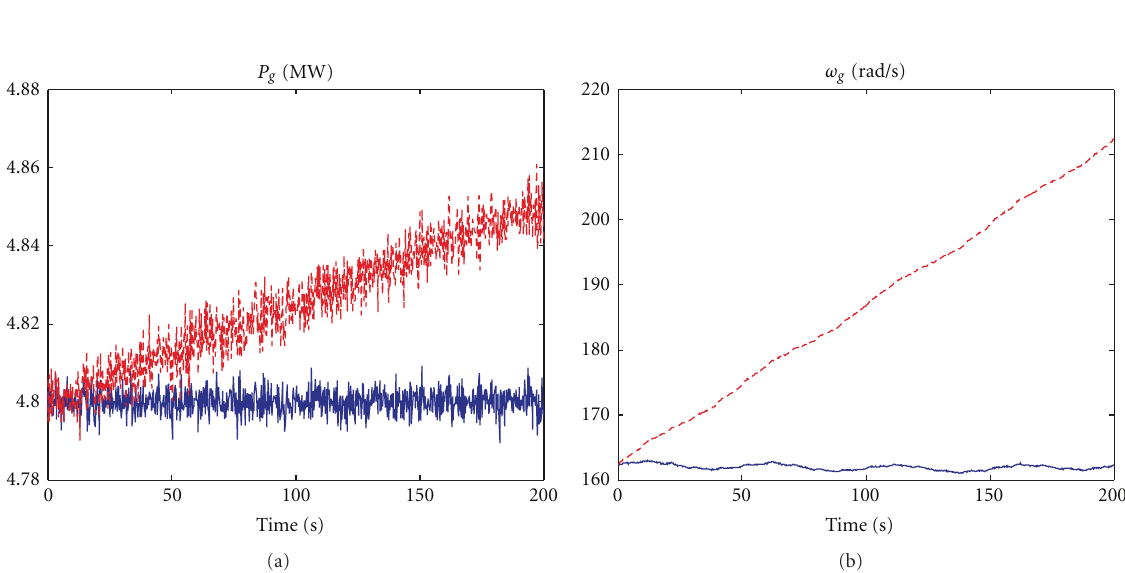
Figure 3: P g and ω g outputs with the fuzzy TS controller.